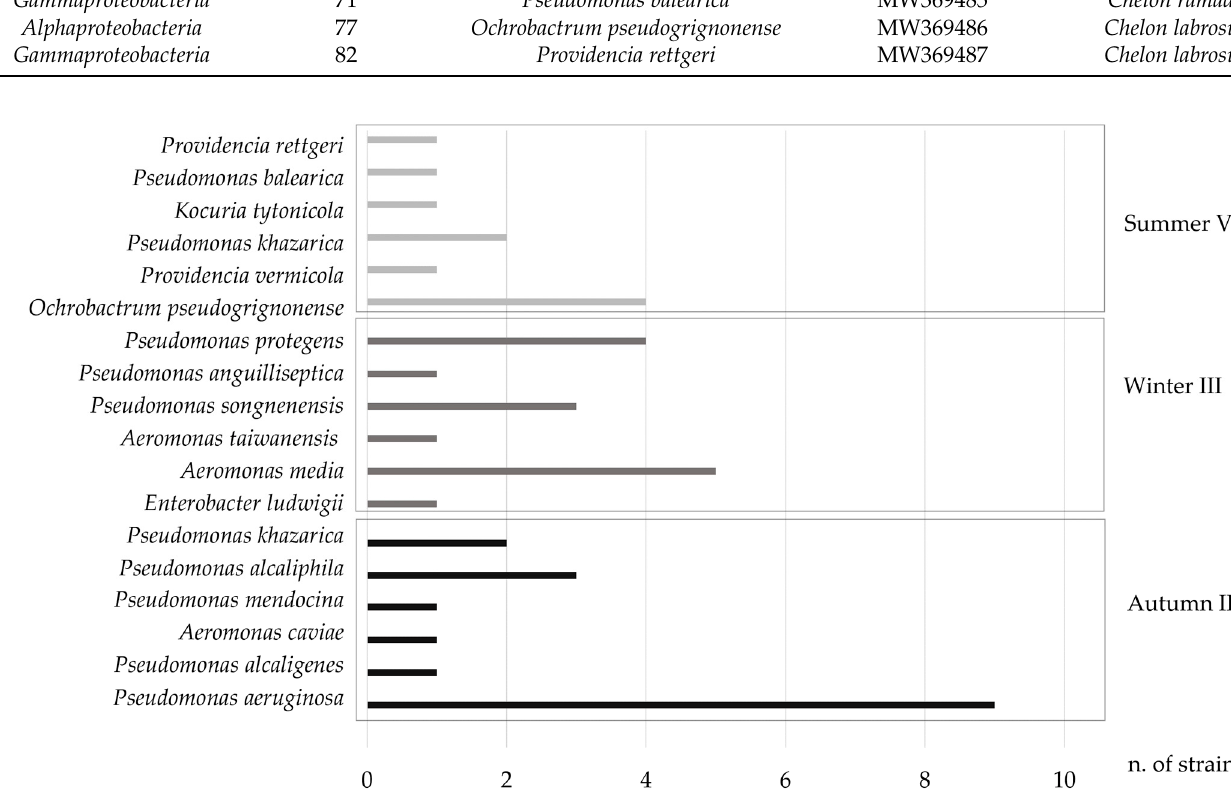
Figure 4. Distribution of intestinal bacterial species isolated along the various seasons.